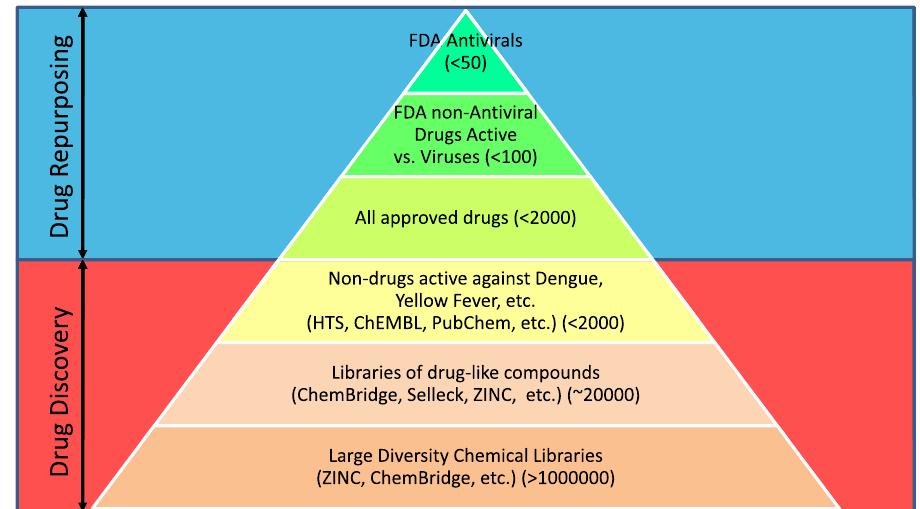
Figure 1. Compounds and chemical libraries suggested for testing against Zika